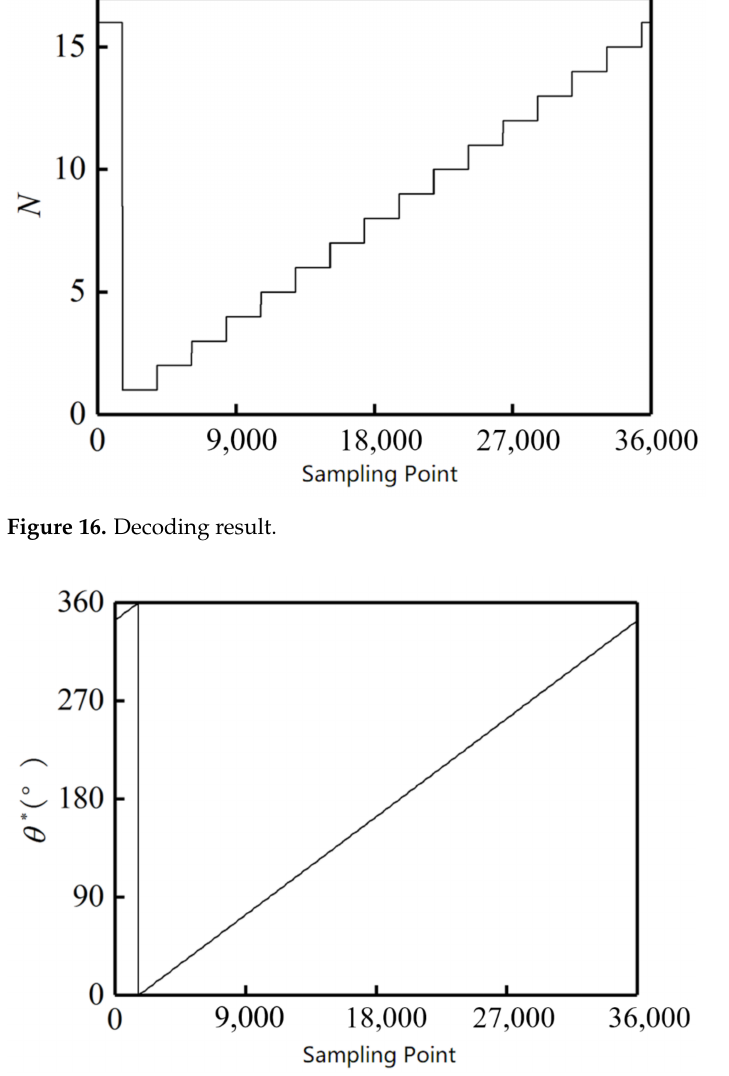
Figure 17. Calculated